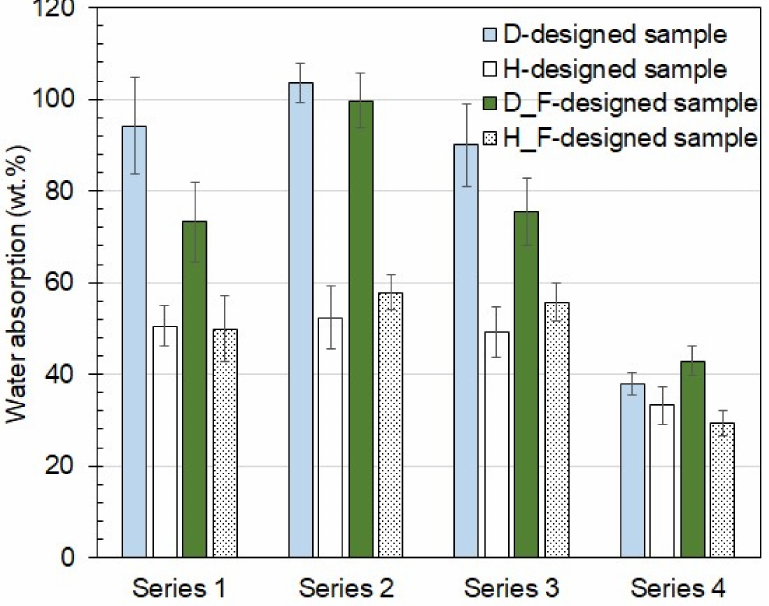
Figure 3. Water absorption of coating films (30-day-long water exposure).